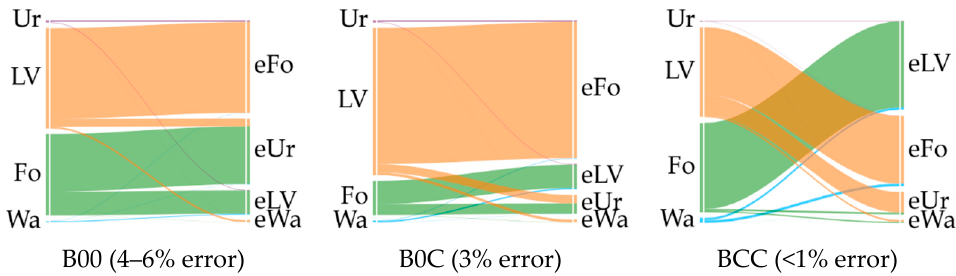
Figure 5. Alluvial diagrams of the errors (OE, CE) as a function of predictor variables used for classification at the temperate site. Left vertical axes show the reference label (Ur, Urban, in purple; LV, low vegetation, in orange; Fo, forest, in green; Wa, water, in blue), right vertical axes show classified label for the misclassified (error—‘e’) pixels. The thickness of the lines indicates error frequency compared to the total error.